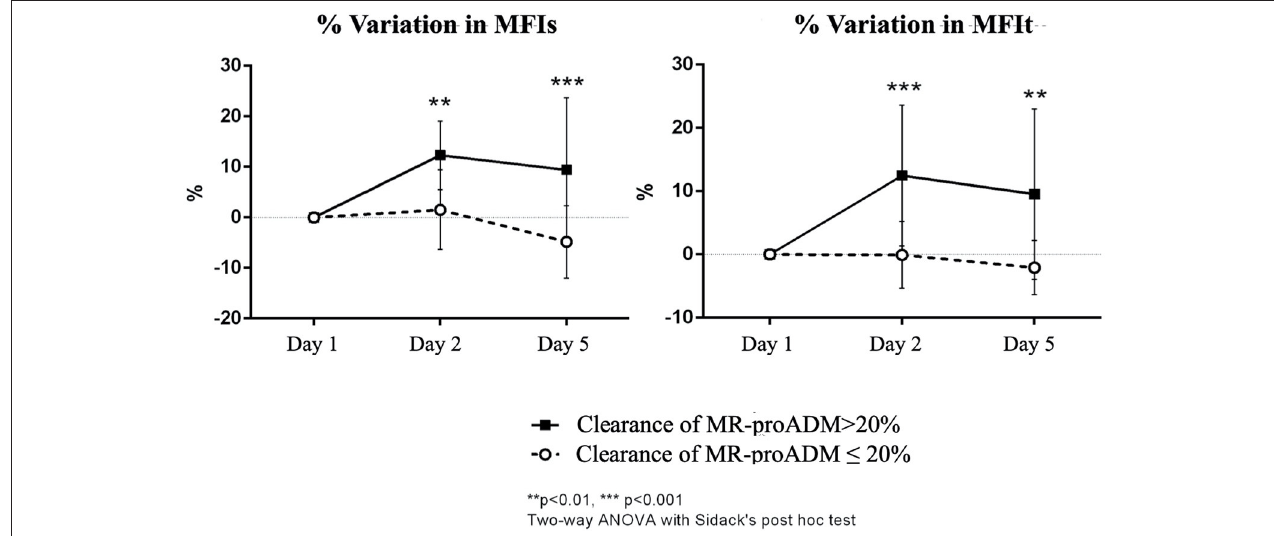
FIGURE 3 | Percentual variation of MFIs and MFIt from baseline in the two groups of patients (clearance of MR-proADM inferior-to-equal or higher than 20%). The two-way ANOVA with the Sidack’s post-hoc test. ** p < 0.01. *** p <